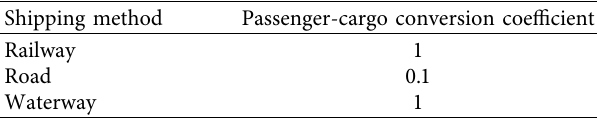
Data source: calculated according to the Chinese statistical